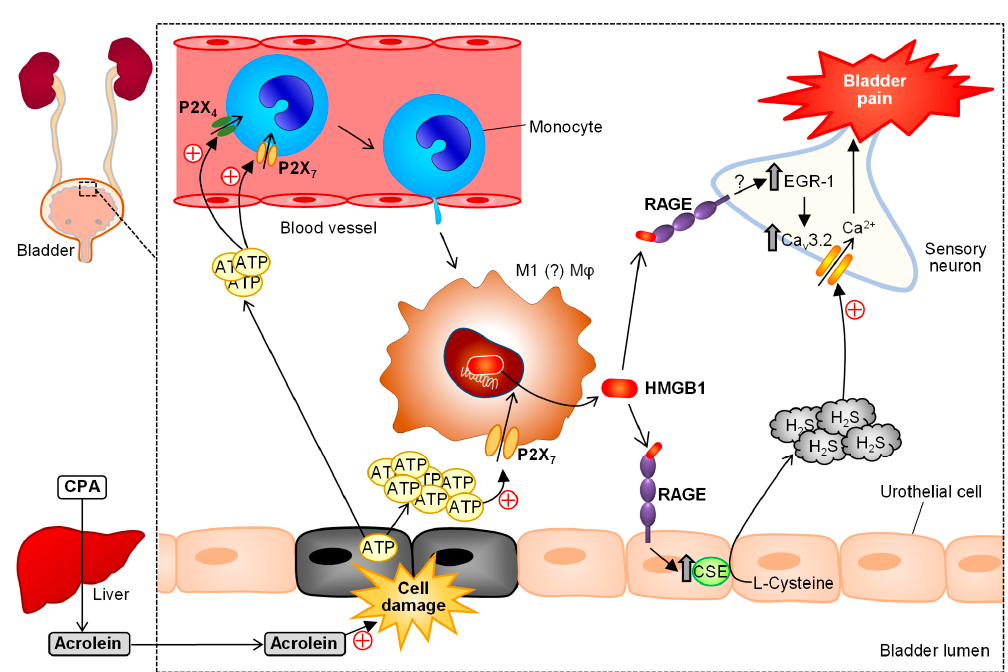
Figure 5. Role of macrophage-derived HMGB1 in the development of cystitis-related bladder pain in mice treated with cyclophosphamide (CPA). Acrolein, a toxic metabolite of CPA, accumulates in the bladder lumen and injures urothelial cells, leading to ATP release. The extracellular ATP causes infiltration of circulating monocytes into the bladder tissue via P2X 4 and P2X 7 receptors, and release of nuclear HMGB1 via P2X 7 receptors. The extracellular HMGB1 induces RAGE-dependent overexpression of cystathionine- γ -lyase (CSE), an H 2 S-generating enzyme, in the urothelium, and the increased H 2 S enhances neuronal Ca v 3.2 channel activity, leading to bladder pain. The HMGB1/RAGE pathway may also be responsible for the EGR-1-dependent transcriptional upregulation of Ca v 3.2 in the sensory neuron following CPA treatment.